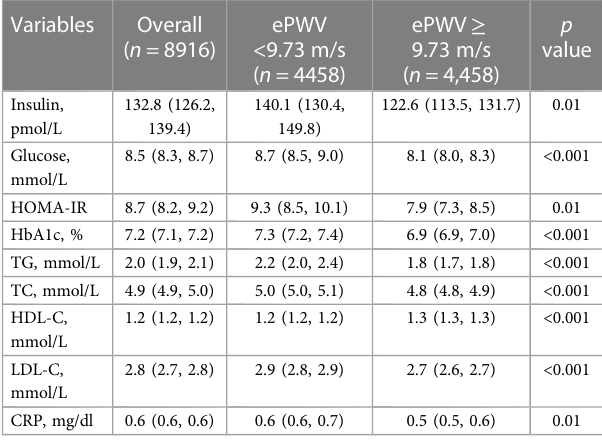
TABLE 2 Cardiometabolic markers of study